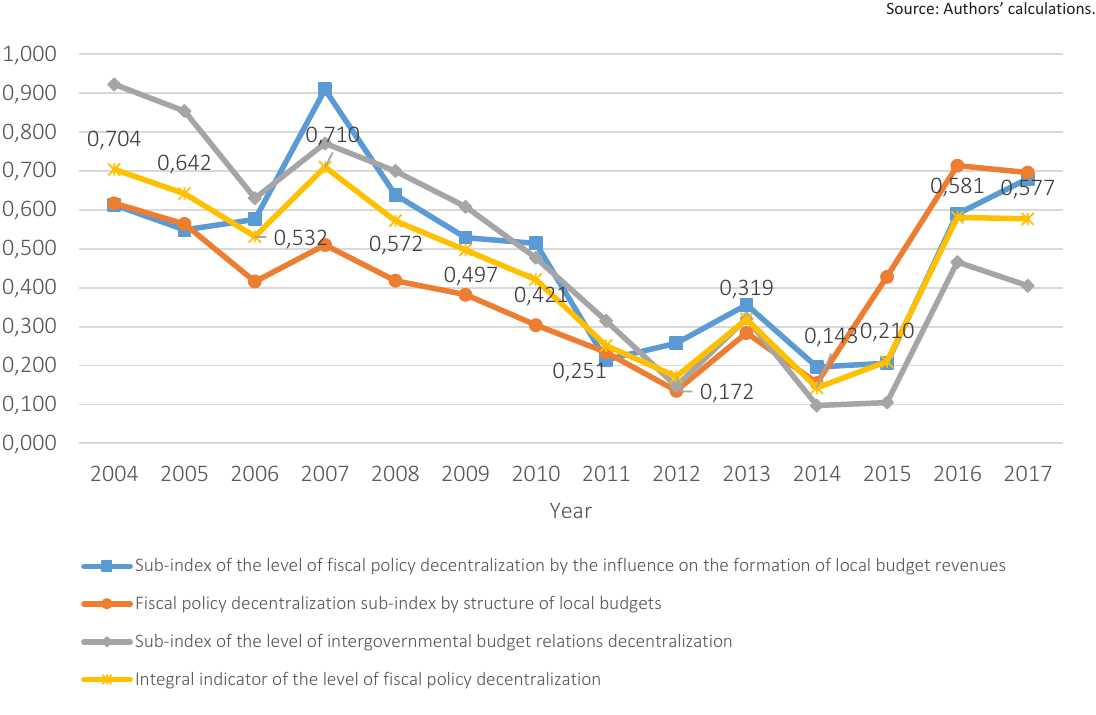
Figure 1. Dynamics of the integral indicator of the level of fiscal policy decentralization in